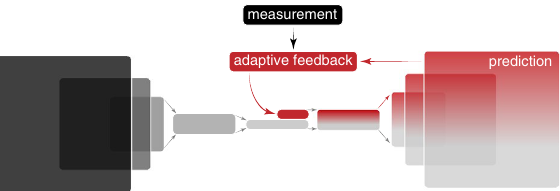
Figure 1. A high level overview of the adaptive ML approach for time-varying systems with flexibility for adaptation added by including an input vector of adaptively tuned parameter that is concatenated together with a vector output of a dense layer within a convolutional neural network after the encoder and before the generative